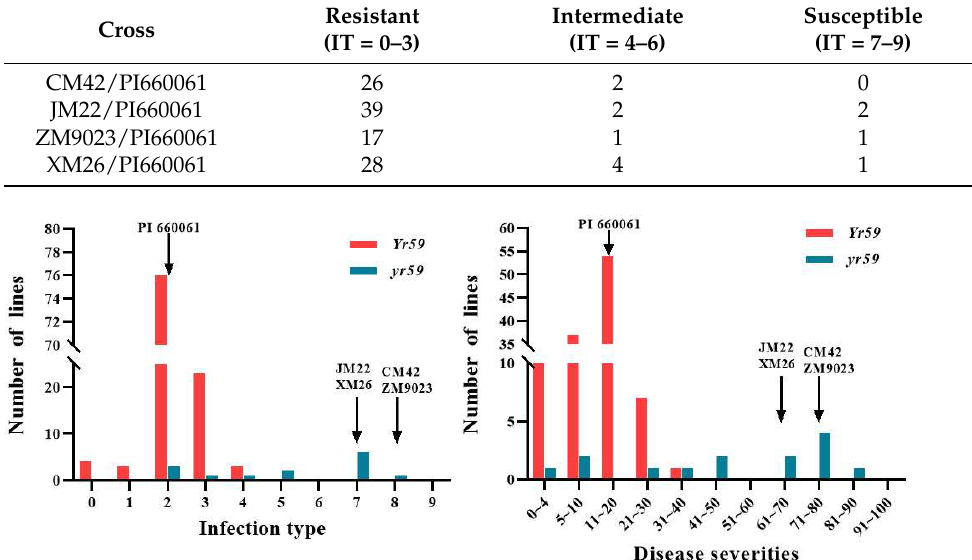
Figure 4. Comparison of 123 ILs for mean final infection type and disease severity about the presence ( Yr59 ) and absence ( yr59 ) of the stripe rust resistance gene Yr59 .